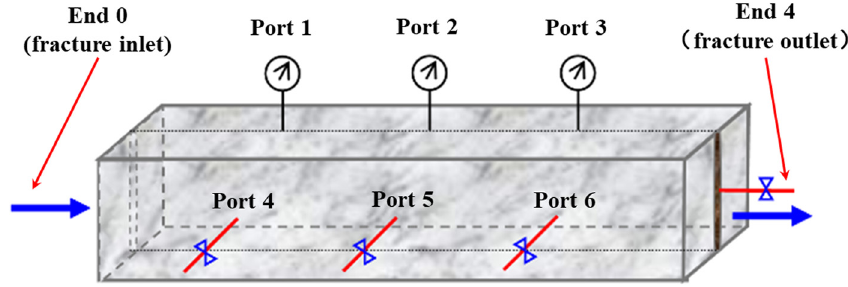
Figure 1: Numbers of sampling ports along the fracture and matrix of cubical core.